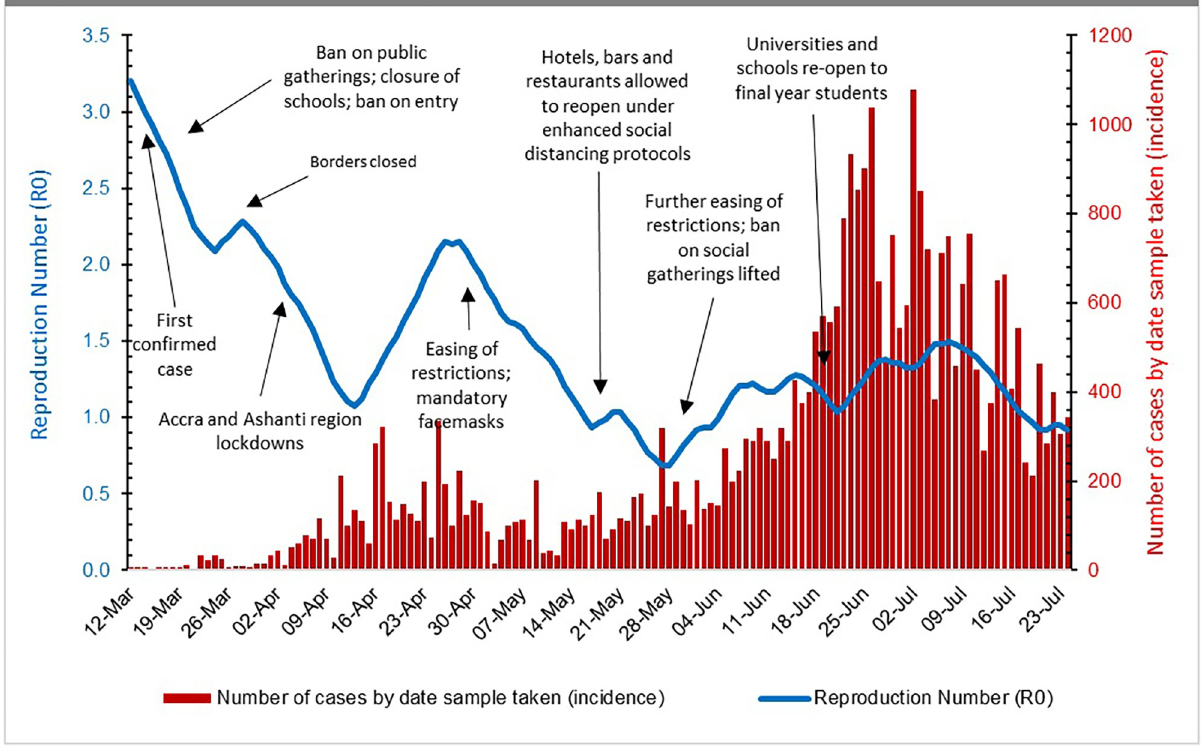
Fig 4. Time dependent R 0 superimposed on daily COVID-19 infections in Ghana.